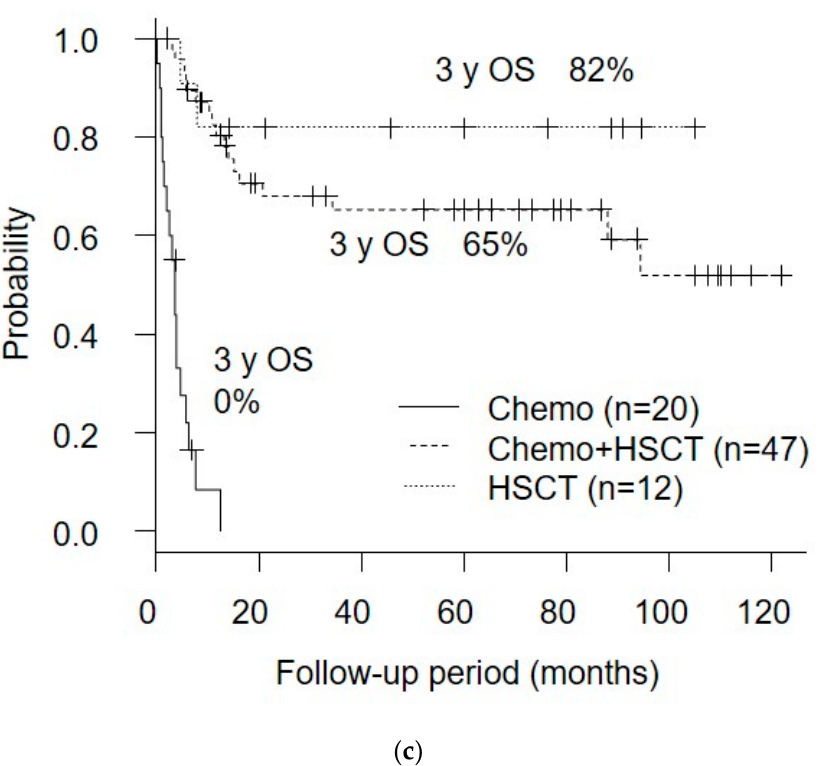
Figure 1. The results of the nationwide fact-finding research of chronic active Epstein–Barr virus infection (CAEBV) treatment in Japan [4]. ( a ) Sexual specificity by age; ( b ) survival rate by age; ( c ) survival rate by treatment method.